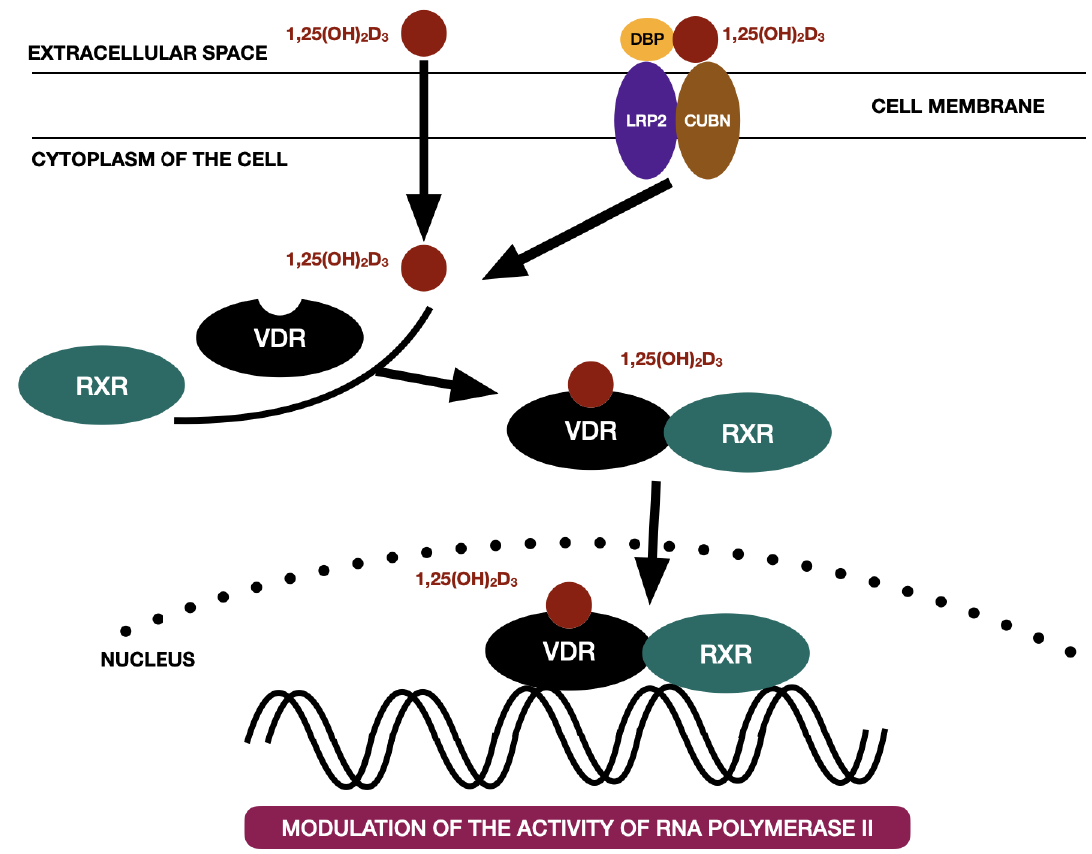
Figure 3. The classic vitamin D 3 pathway on the basis of the literature [38]. 1,25(OH) 2 D 3 —calcitriol, CUBN—cubilin, DBP—vitamin D binding protein, LRP2—LDL receptor-related protein 2, RXR— retinoid X receptor, VDR—vitamin D receptor.